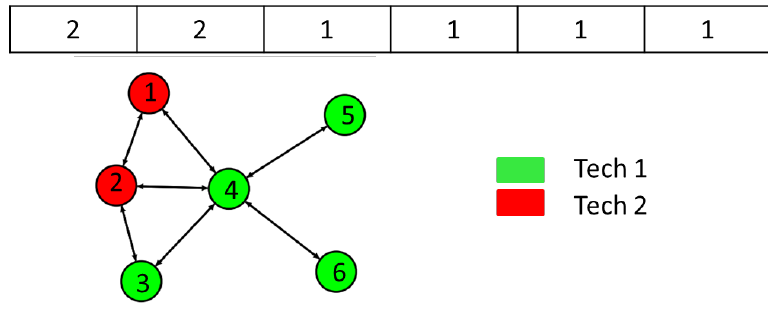
Figure 5. Chromosome coding for the reliable node placing